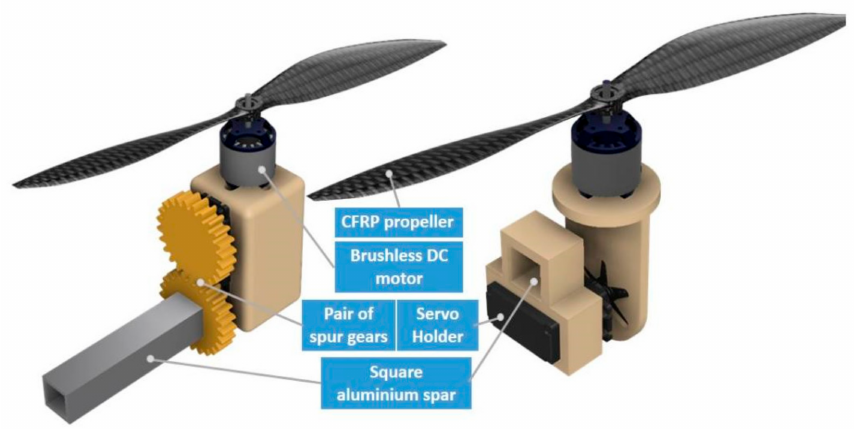
Figure 3. Iterations of the motor pod conceptual